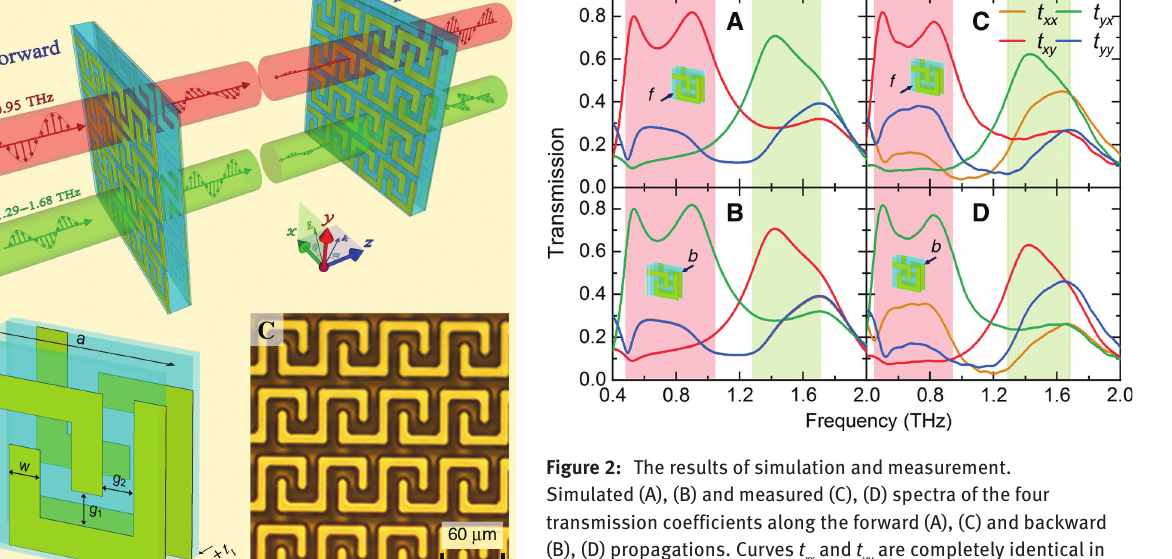
and t are completely identical in xx yy